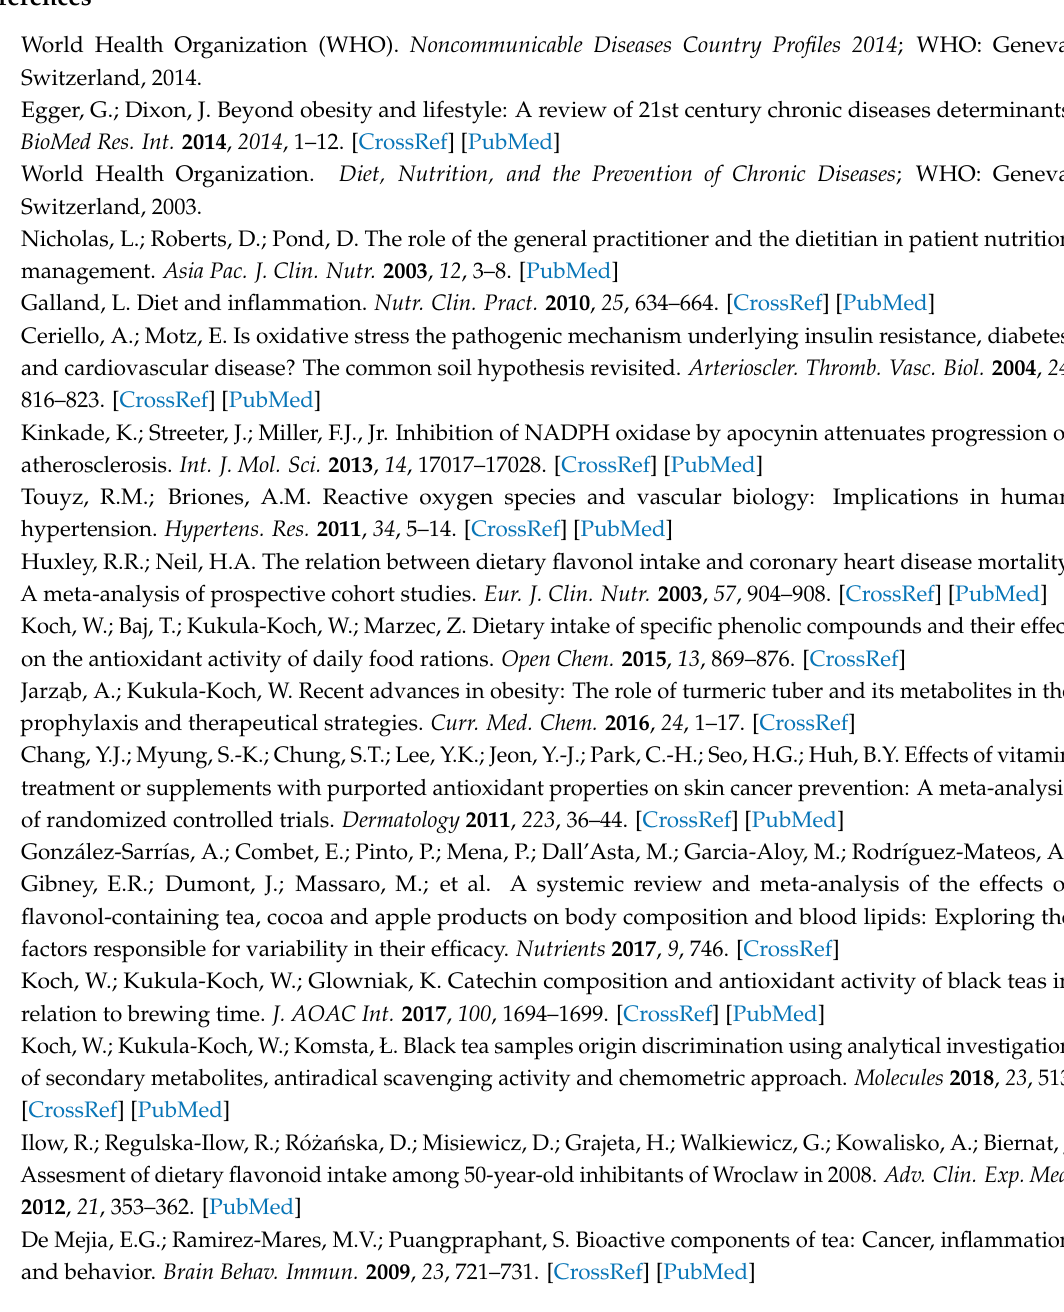
Supplementary Materials: The following are available online. Figure S1: Fragmentation spectra of all identified catechins and gallic acid obtained at the collision energy of 20 V in the negative ionization mode. Figure S2. Statistical significance of each parameter, separately. Table S1: Accurate mass measurements and identification data of catechins in the studied samples. Dataset S1: The raw data obtained from Principal Components